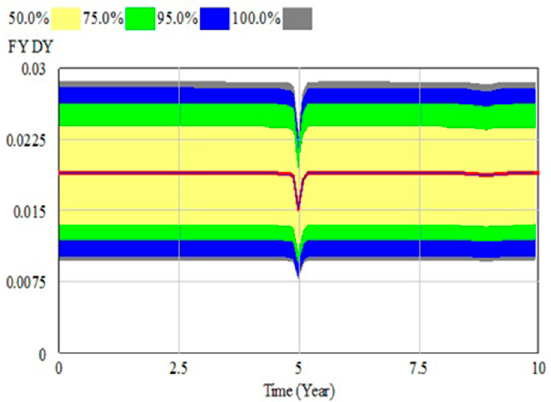
Figure 22. SD sensitivity trace range of fire ignition probability variable.